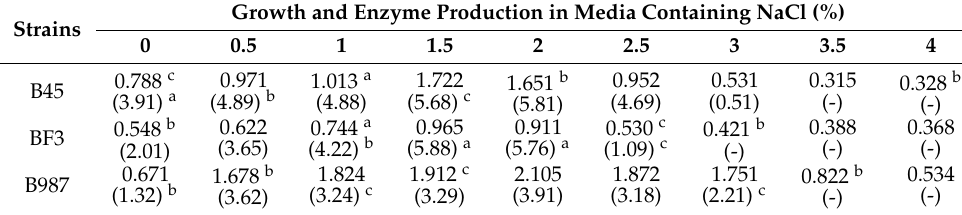
Table 3. Growth and enzyme production in presence of sodium chloride. The isolates, B45, BF3 and B987 were cultivated in Mineral salt medium containing carboxymethylcellulose, xylan or pectin and amended with sodium chloride. The OD 600 (corresponded to 2.8–3.2 × 10 8 cells per mL) was taken as reflection of the growth. Endoglucanase, xylanase and pectinase was assayed from the strain B45, BF3 and B987, respectively. The enzyme titres (IU mL − 1 ) are given in the parenthesis.